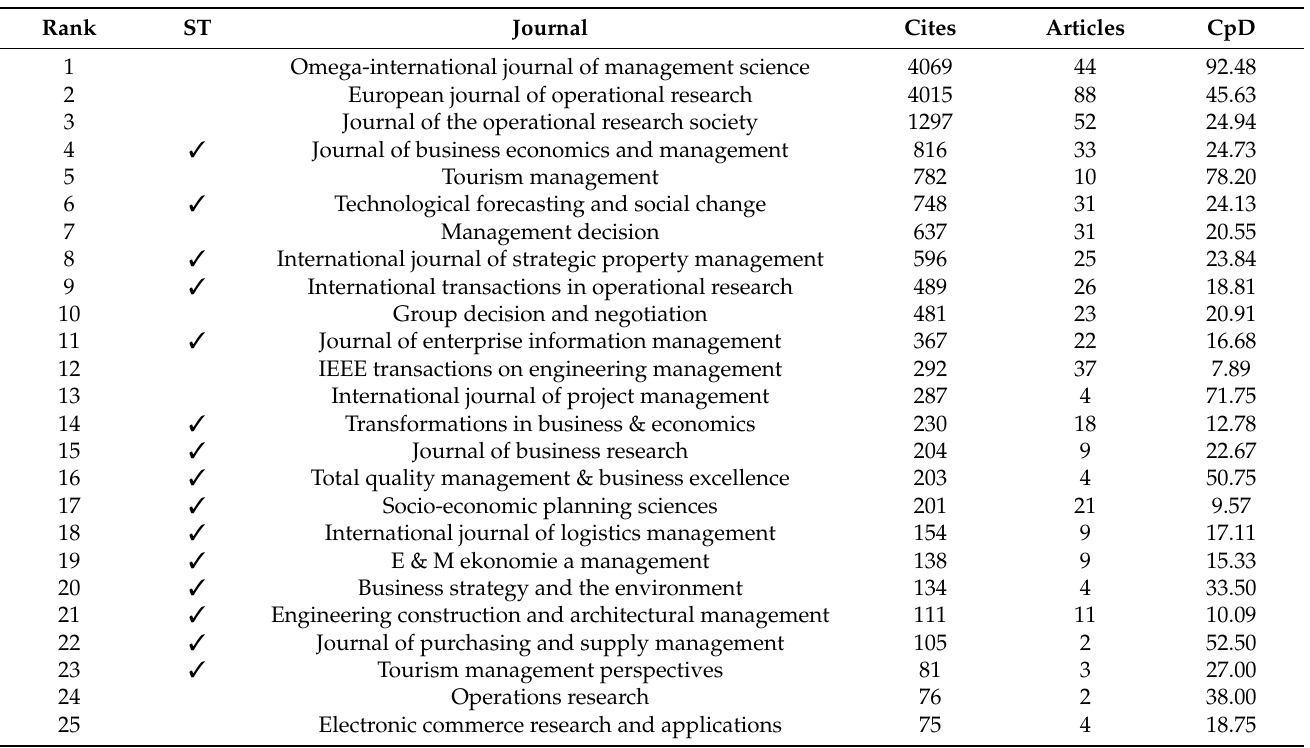
Table A6. Top 25 journals in period 2 (2009–2022) for